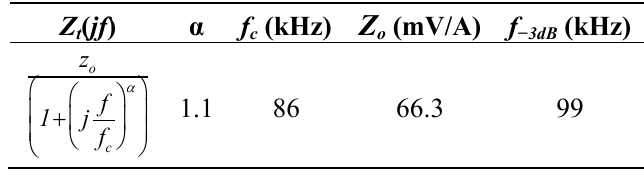
Table 3. TMR sensor without internal magnetization ac large-signal fractional modeling parameters.